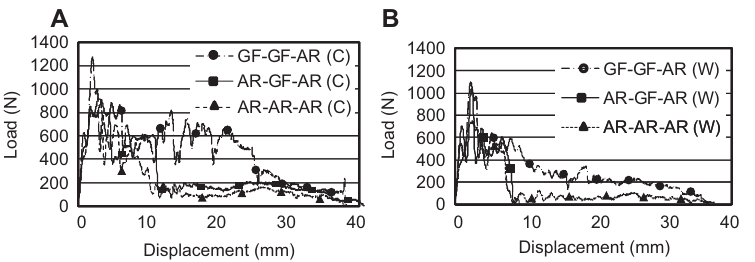
Figure 5 Load-displacement curves of the BWK composites during the three-point bending impact test – effect of biaxial yarn: (A) course (C) direction and (B) wale (W)